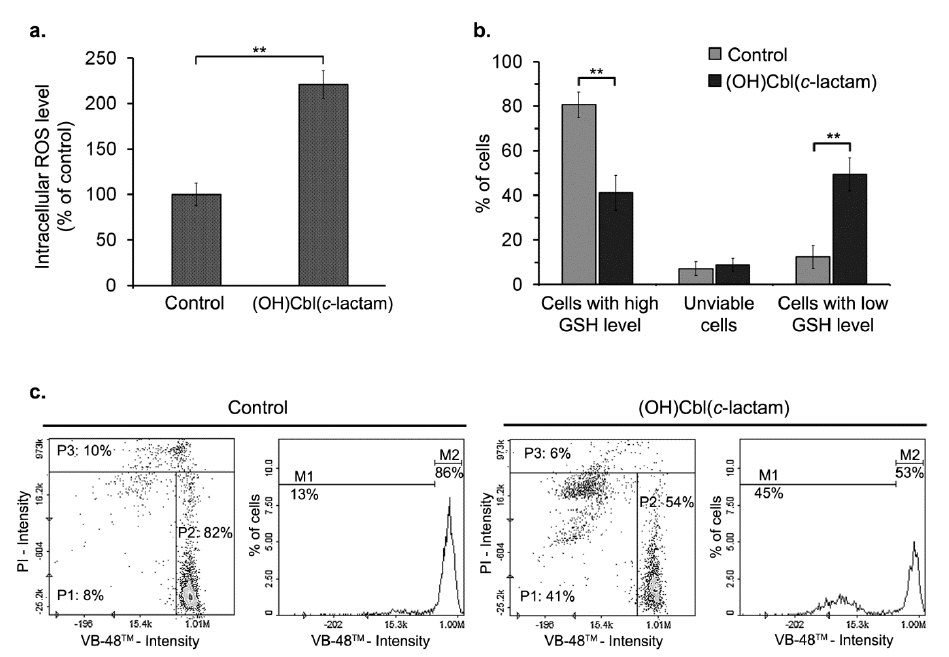
Figure 5. Redox homeostasis in melanocytes under conditions of vitamin B 12 deficiency. HEMn-DP cells were cultured in medium supplemented with (OH)Cbl( c -lactam) in concentration 10 µ g/mL for 24 days. Control melanocytes were cultured in parallel in standard growth medium. ( a ) Intracellular reactive oxygen species (ROS) level determined by H 2 DCFDA assay and calculated as the percentage of control. ( b ) Bar graphs showing the percentage of viable cells with low or high Glutathione (GSH) level and dead cells. Data presented as the mean values of three independent experiments ± SD;